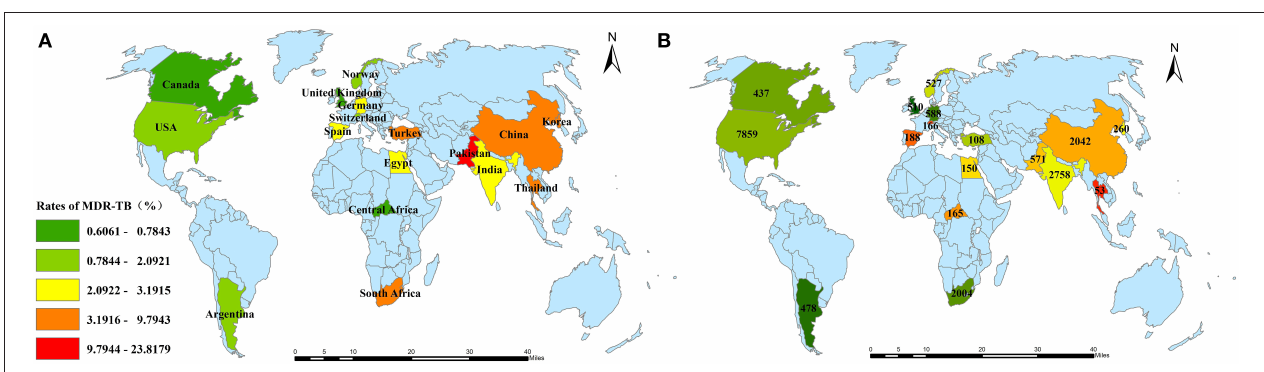
FIGURE 2 | Geographic distribution. (A) the rates of MDR-TB in each country; (B) the number of pediatric TB cases with drug susceptibility results from each country. TB, tuberculosis; MDR-TB, multidrug resistant